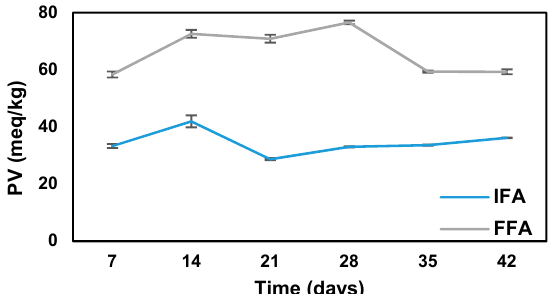
Figure 4. Peroxide values (PV, mean value ± SD) of FFA (free fatty acid; OLLn) and IFA (intercalated fatty acid; MgAl-OLLn) series during heating.